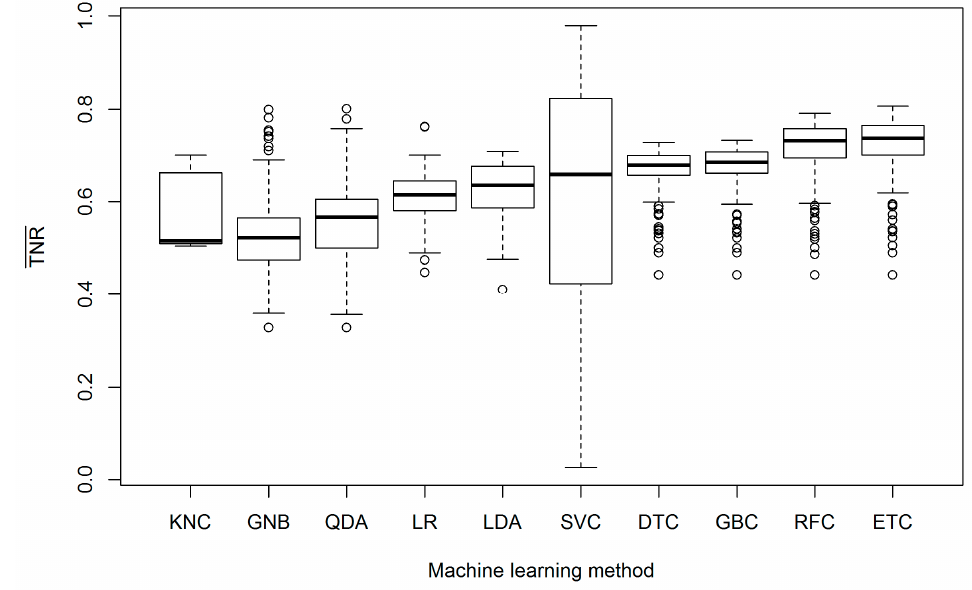
Figure 6. Box plots of mean sensitivities ( 𝑇𝑃𝑅(cid:3364)(cid:3364)(cid:3364)(cid:3364)(cid:3364)(cid:3364) ) of FDMs generated by MLAs. Box plots show me- dian plus upper and lower quartiles for mean sensitivities of all FDMs generated by a given algo- rithm. Minimum and maximum values are indicated by the upper and lower whiskers (1.5 × inter- quartile range). Circles are outliers. See Table 3 for MLA codes.